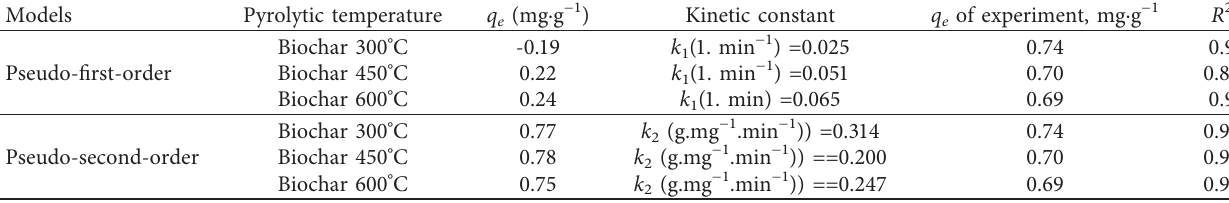
Table 5: NH + adsorption kinetics parameters of 4